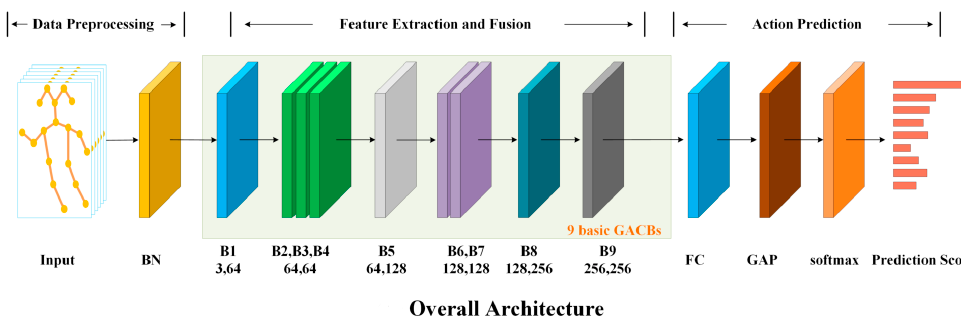
Figure 1. The Overall network of GATCN, which takes joints as example input.